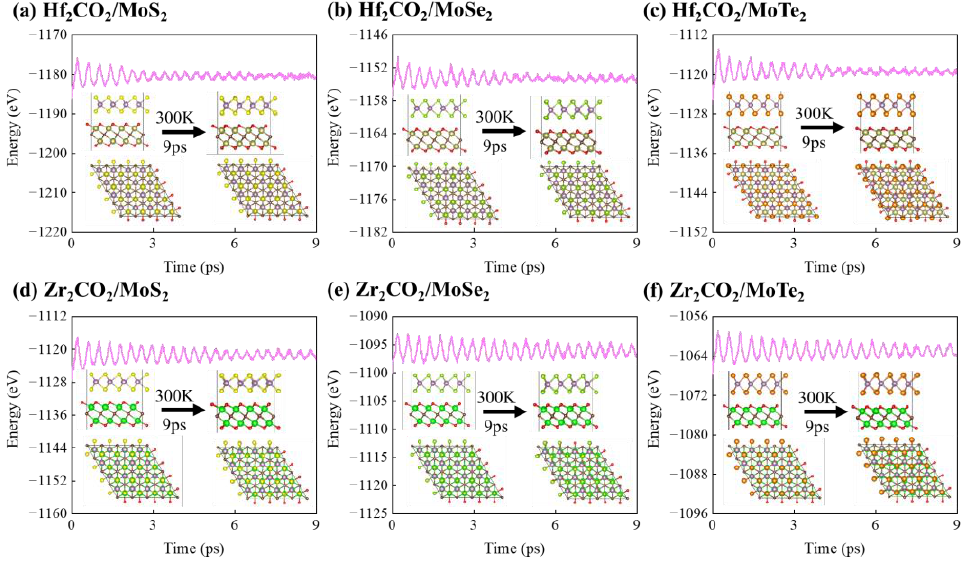
Figure 3. The evolutions of total energy and structure snapshots from AIMD simulations of ( a ) Hf 2 CO 2 /MoS 2 , ( b ) Hf 2 CO 2 /MoSe 2 , ( c ) Hf 2 CO 2 /MoTe 2 , ( d ) Zr 2 CO 2 /MoS 2 , ( e ) Zr 2 CO 2 /MoSe 2 , and ( f ) Zr 2 CO 2 /MoTe 2 heterostructures.